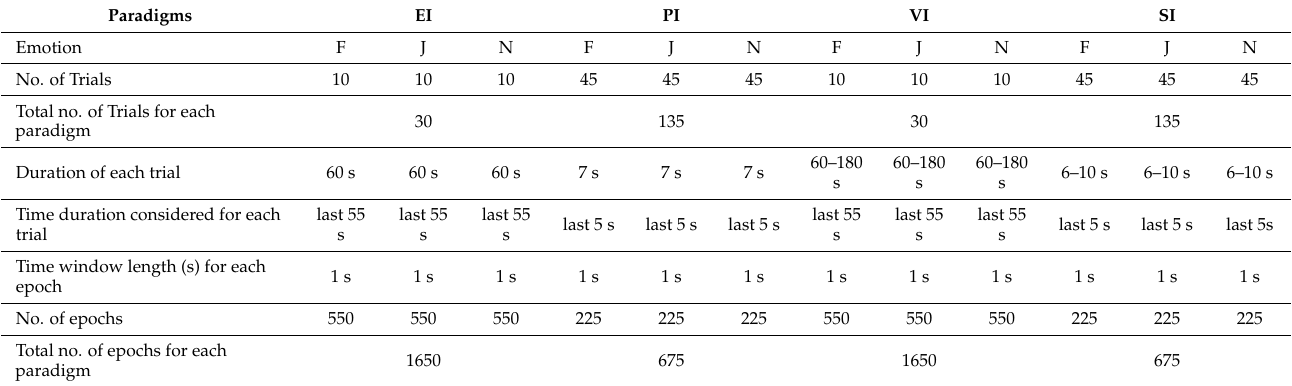
Table 2. Blocks distribution with respect to emotion-inducing paradigm and emotional